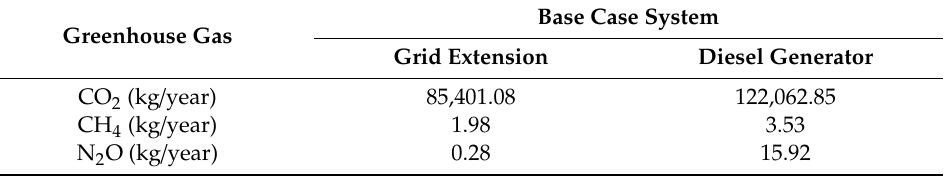
Table 8. GHG emission savings of the proposed system in comparison to the traditional